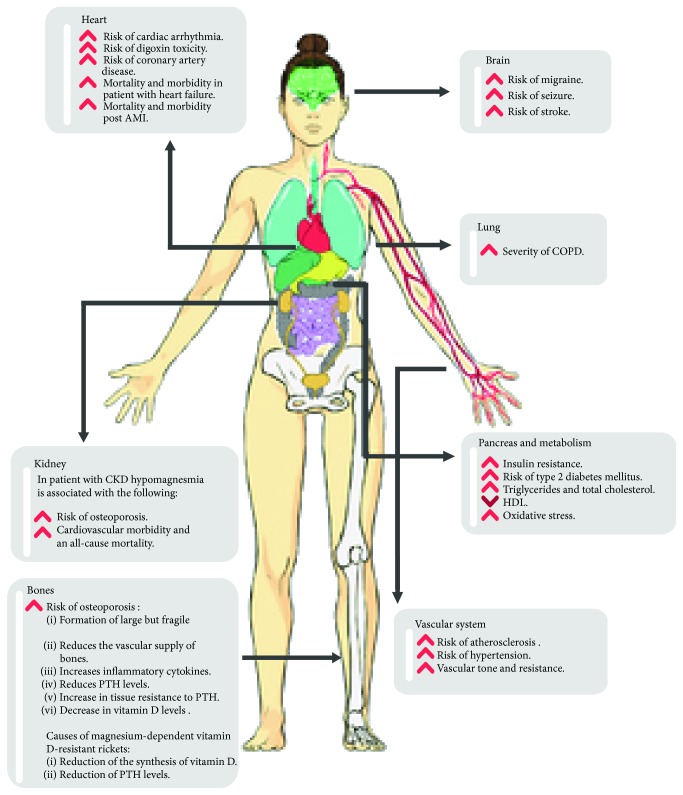
Impact of hypomagnesemia.